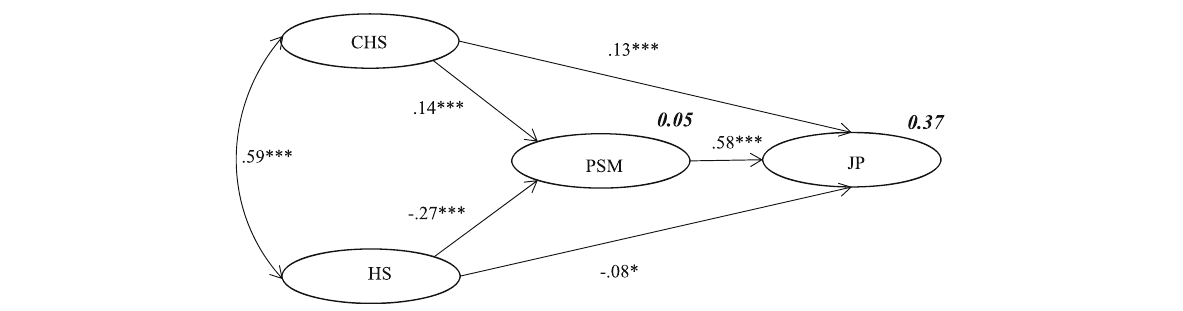
Fig. 2 Final model illustrating how challenge stress (CHS), hindrance stress (HS), and public service motivation (PSM) influence job performance (JP) (numbers not in bold are standardized regression coefficients, and numbers in bold explain variability; chi-square, 974.925; degrees of freedom, 160, p <0.001; root mean square error of approximation, 0.057; normed fit index, 0.943; comparative fit index, 0.952; *** p <0.001, ** p <0.01,* p <0.05)